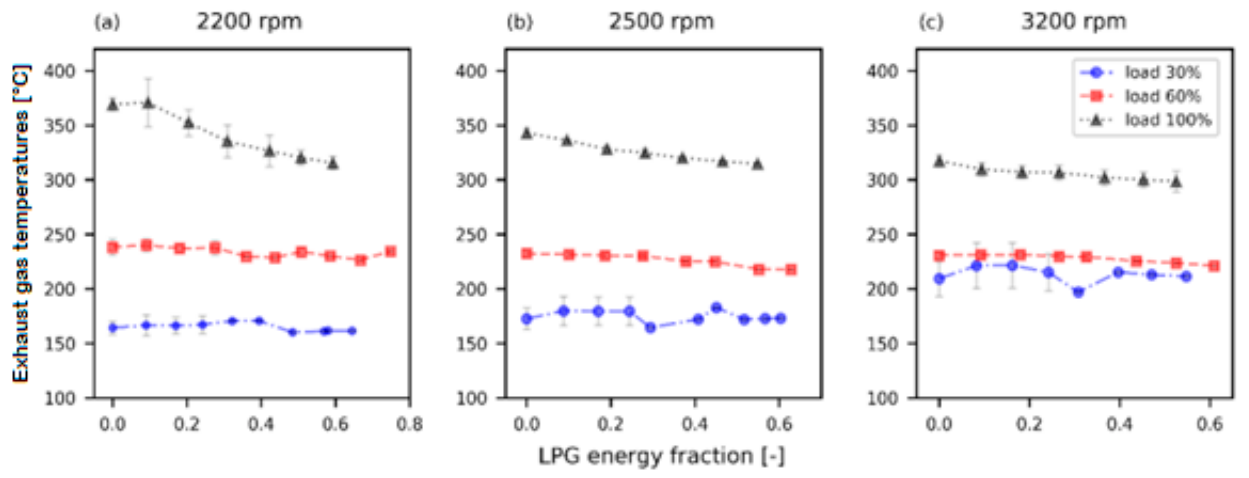
Figure 10. Exhaust gas temperatures v/s LPG energy fraction at ( a ) 2200 rpm, ( b ) 2500 rpm, and ( c ) 3200 rpm. Table 4 highlights the most important findings for gaseous emissions in dual operation. Table 4. Most important findings for gaseous emissions in dual operation.